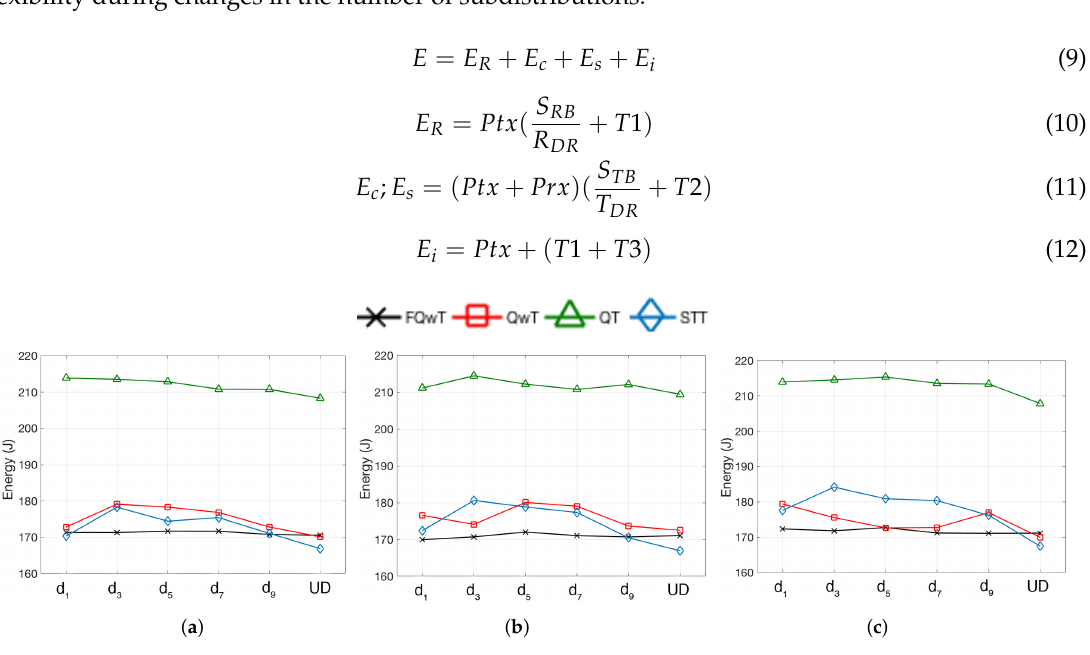
Figure 15. Simulation results obtained for the energy consumption for different tag subdistributions, when FPL is 20, 60 and 100, and d m varies from d 1 to UD. ( a ) FPL = 20; ( b ) FPL = 60; ( c ) FPL =